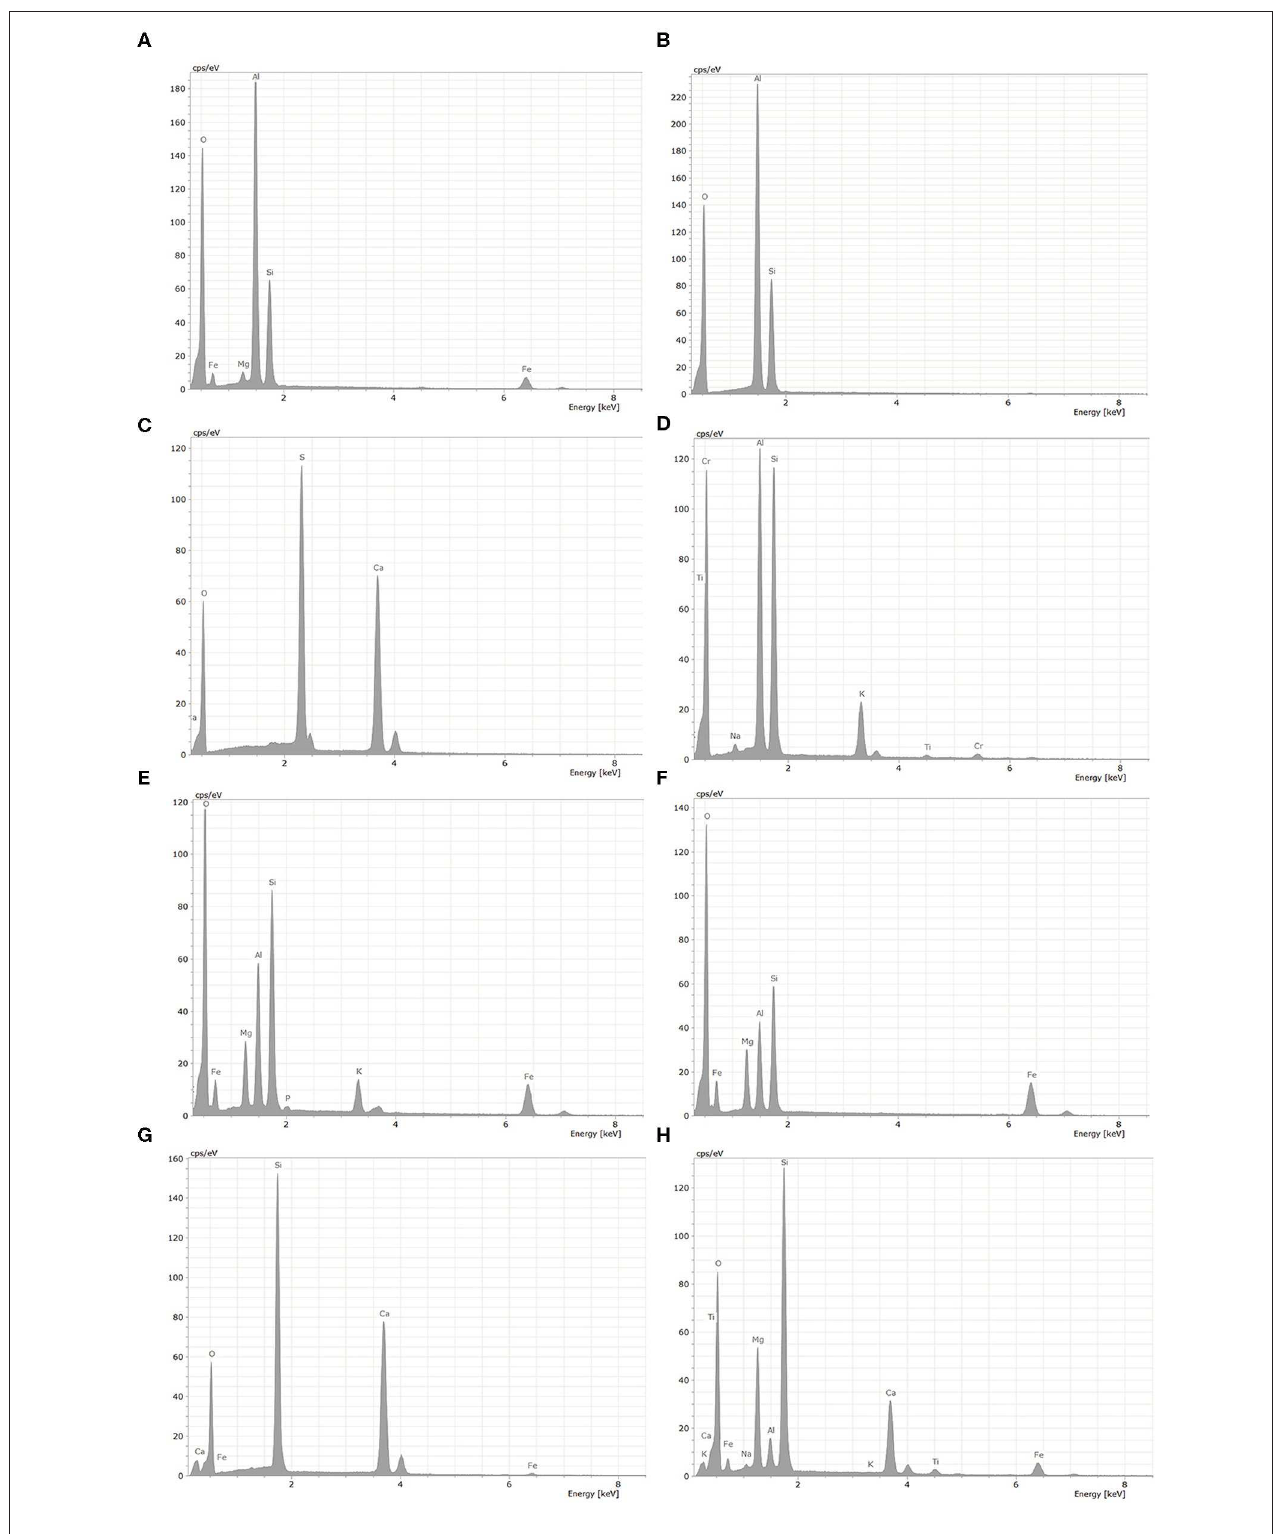
FIGURE 6 | X-ray spectra (EDS) of minerals obtained using EPMA: (A) Staurolite and (B) kyanite in Kelogi 9; (C) anhydrite in Naibor Soit Kubwa 6; (D) fuchsite in Naibor Soit Ndogo 13; (E) biotite in Naisiusiu 4; (F) glauconite in Naisiusiu 7; (G) wollastonite in A1A; (H) kaersutite in A6. Refer to Table 2 and Supplementary Section 1 for additional sample information. Refer to Supplementary Figures 22, 27, 33, 37, 39, 46, 49 for unclipped spectra.